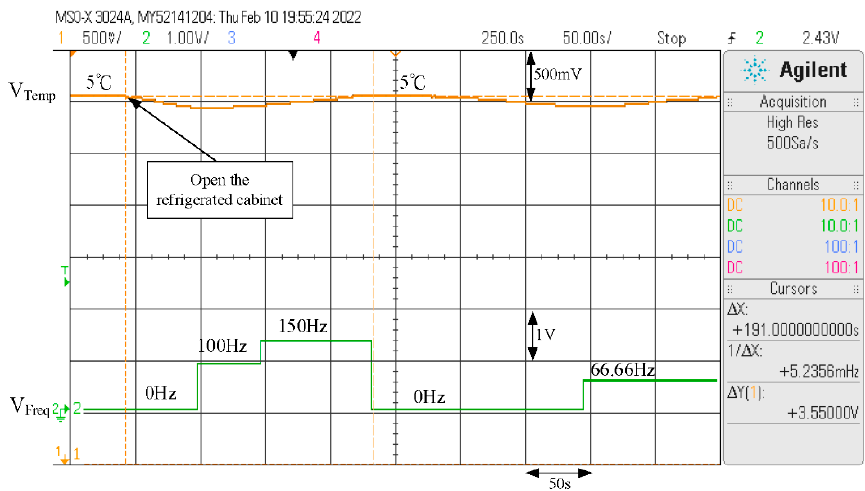
Figure 36. Response of the temperature control with the conventional P-I controller.